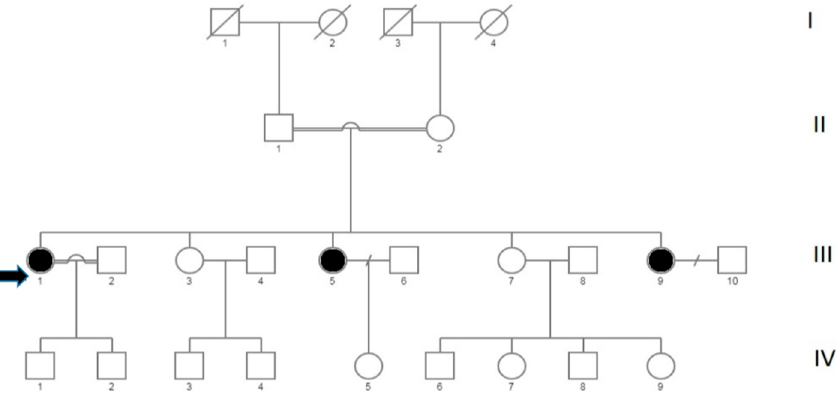
Figure 1. Pedigree of the family with LGMD. Solid symbols represent the affected state, open symbols represent the unaffected individuals. Double lines indicate consanguineous marriage. The proband is indicated with an arrow.